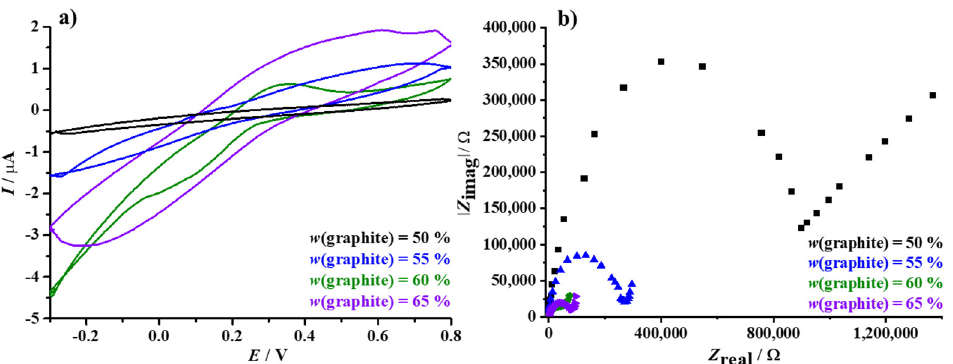
Figure 4. Cyclic voltammograms ( a ) and impedance spectra ( b ) of the graphite disk electrode modified with a transducer layer of different wt % graphite, both recorded in the presence of [Fe(CN) 6 ] 4 − /3 − redox probe and 0.1 M KCl background electrolyte. CV and EIS parameters are also noted in the previous Figure.